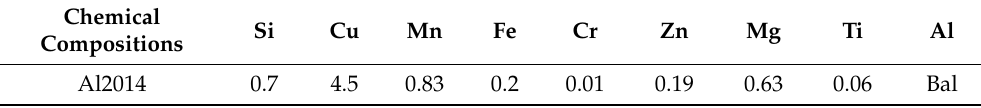
Table 1. Chemical composition of Al2014 alloy by wt.%’